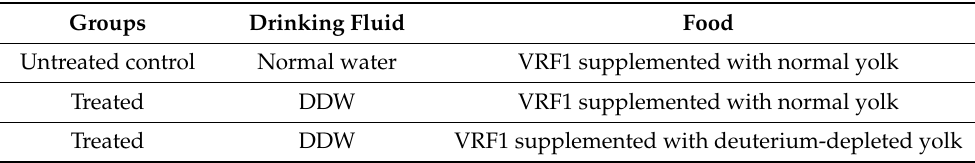
Table 2. Groups and treatments in the second mouse study using the MCF-7 cell line. Groups Drinking Fluid Food Untreated control Normal water VRF1 supplemented with normal yolk Treated DDW VRF1 supplemented with normal yolk Treated DDW VRF1 supplemented with deuterium-depleted yolk